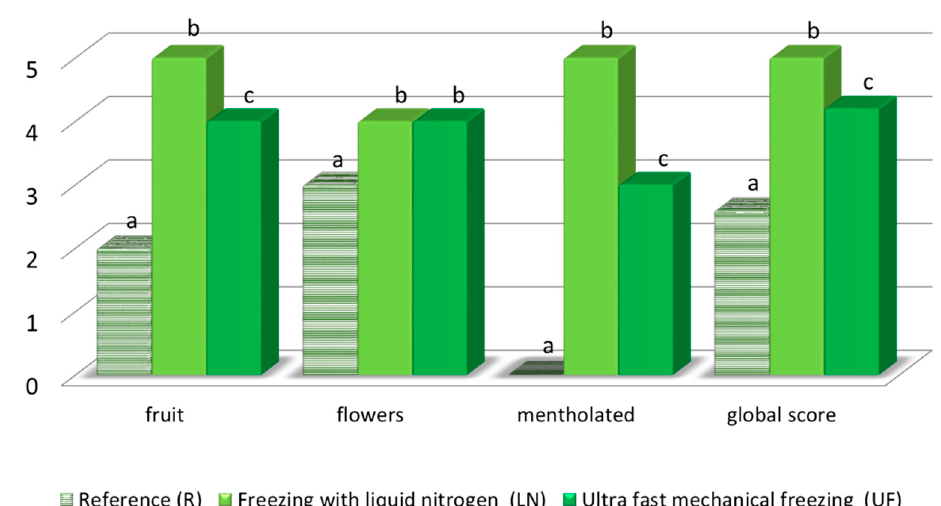
Figure 8. Panel tasting results for R, LN and UF wines. Different letters indicate a significant difference ( p -value < 0.05) for each parameter.